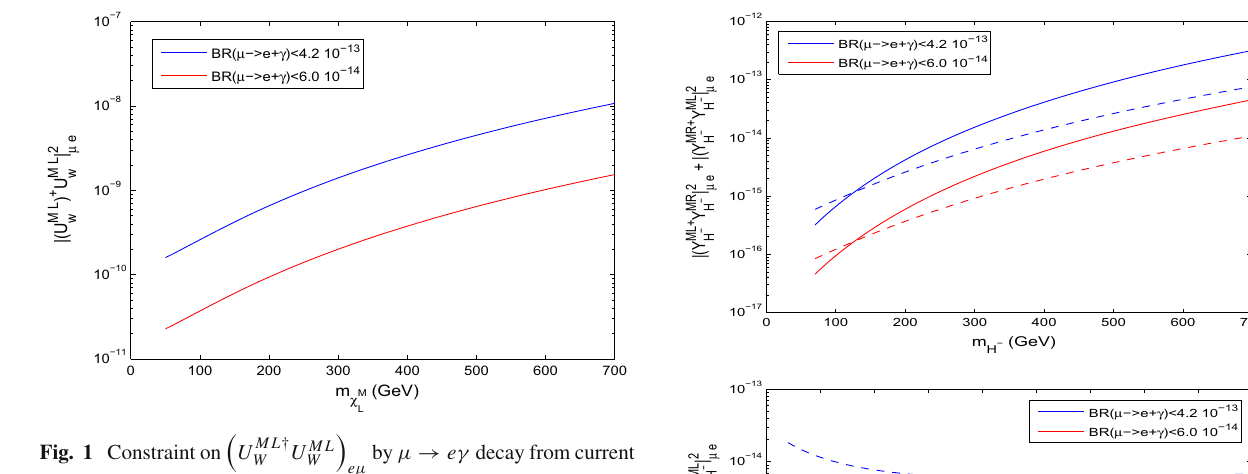
Fig. 1 Constraint on (blue line) and future expected (red line) sensitivities as a function of heavy neutrino mass m M χ